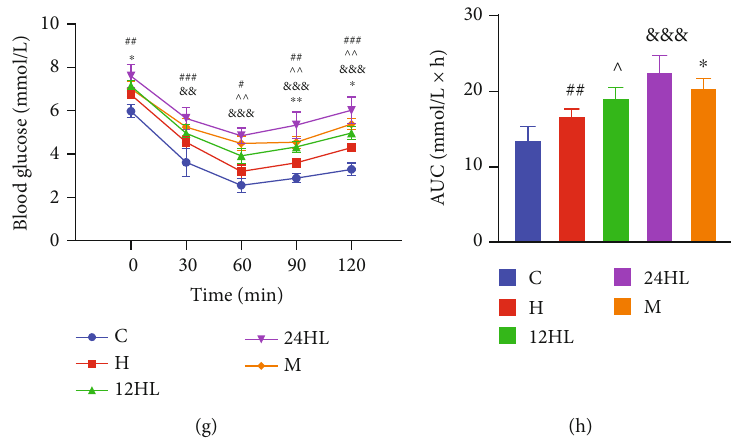
Figure 2: E ff ect of melatonin on OGTT and ITT before or after treatment. (a) OGTT, (b) AUC of OGTT, (c) ITT, and (d) AUC of ITT before treatment (on week 6); (e) OGTT, (f) AUC of OGTT, (g) ITT, and (h) AUC of ITT after treatment (on week 10). C: control group; H: HFD group; 12HL: 12 h light group; 24HL: 24h light group; M: melatonin group. The values are expressed as the means ± S : D : ( n = 7 -12 per group). # P < 0 : 05 , ## P < 0 : 01 , and ### P < 0 : 001 , HFD vs. control; ^ P < 0 : 05 , ^^ P < 0 : 01 , and ^^^ P < 0 : 001 , 12HL vs. HFD group; & P < 0 : 05 , && P < 0 : 01 , and &&& P < 0 : 001 , 24HL vs. 12HL group; ∗ P < 0 : 05 , ∗∗ P < 0 : 01 , and ∗∗∗ P < 0 : 001 , M vs. 24HL